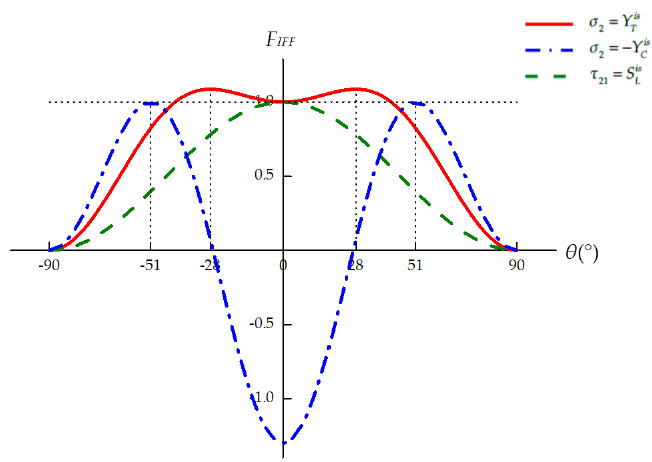
Figure 3. F IFF – θ relation under simple stress states for the ply embedded in a multidirectional laminate. Under transverse compression, the corresponding in situ strength is denoted as Y is